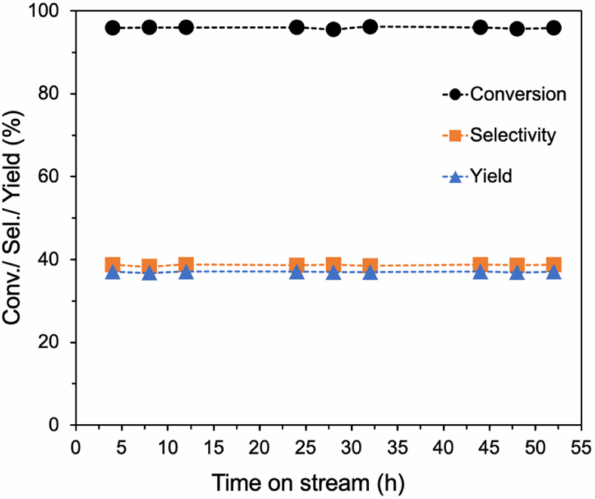
Figure 9. Stability studies of ammonia-evaporated MgO-SiO 2 -4. Reaction conditions: 0.1 g catalyst, 1.5 g glass beads, 475 ◦ C, 55 mL/min He and 400 µ L/h ethanol (11.6 vol%